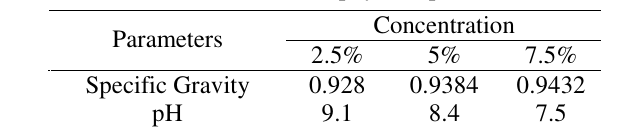
Table 3 . Evaluation of physical parameters.